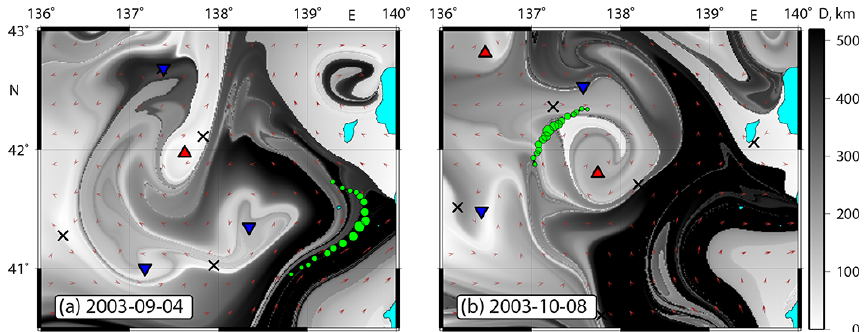
Figure 7. The drift maps in (a) September and (b) October of 2003 with snapshots of the drifter’s track superimposed show how the vortex pair facilitates transport of subtropical tracers to the northwest through the eastern